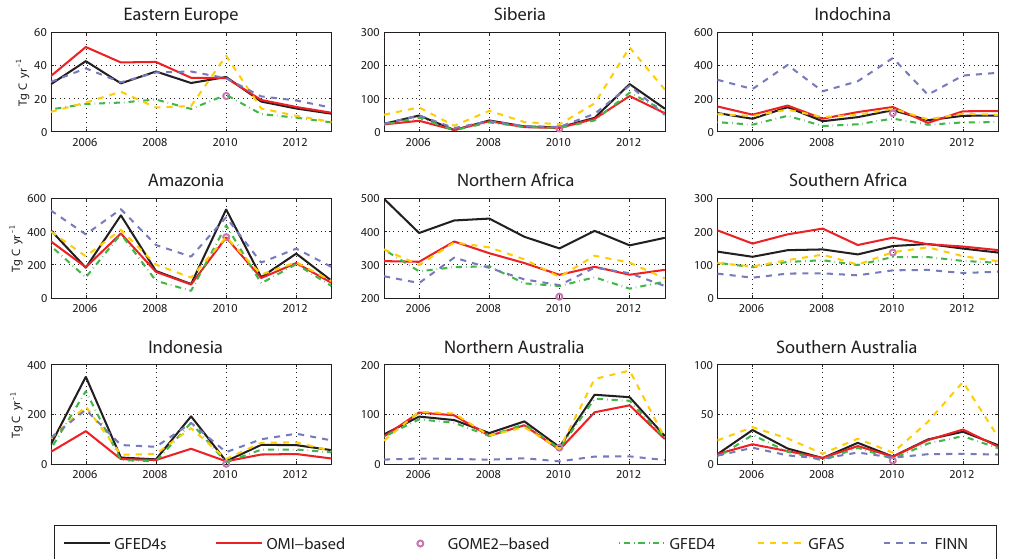
Figure 7. Interannual variation of burned biomass (in Tg Cyear − 1 ) over 2005–2013 from the a priori inventory (black), the satellite-based estimates (OMI in red), and from other bottom–up inventories (GFED4 in green, GFAS in orange, FINN in blue) over small regions defined in Fig. 3. Units are Tg Cyear − 1 . The GOME-2-inferred estimate is shown as magenta circle.